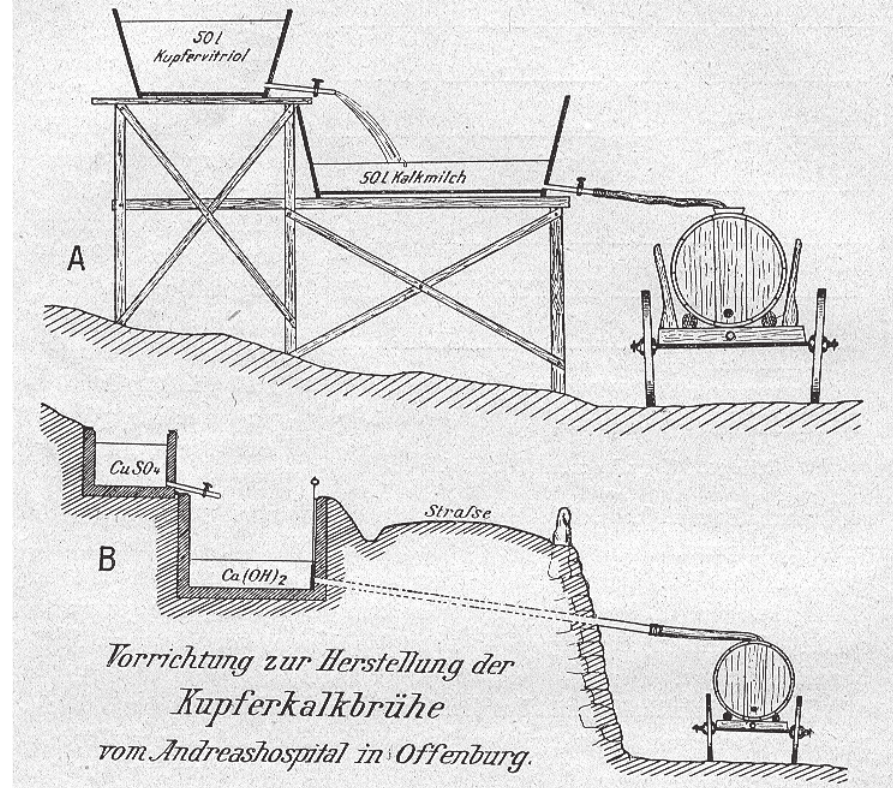
Figure 13. Gun form recommended for treatment of the lower leaf surface (drawing from Müller,